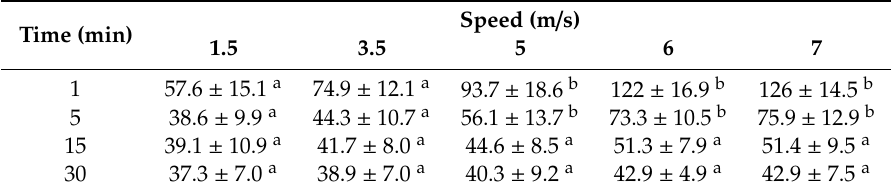
Table 2. Recovery heart rate at di ff erent times after 10 min of exercise at di ff erent speeds (mean ± SD; 7 horses).